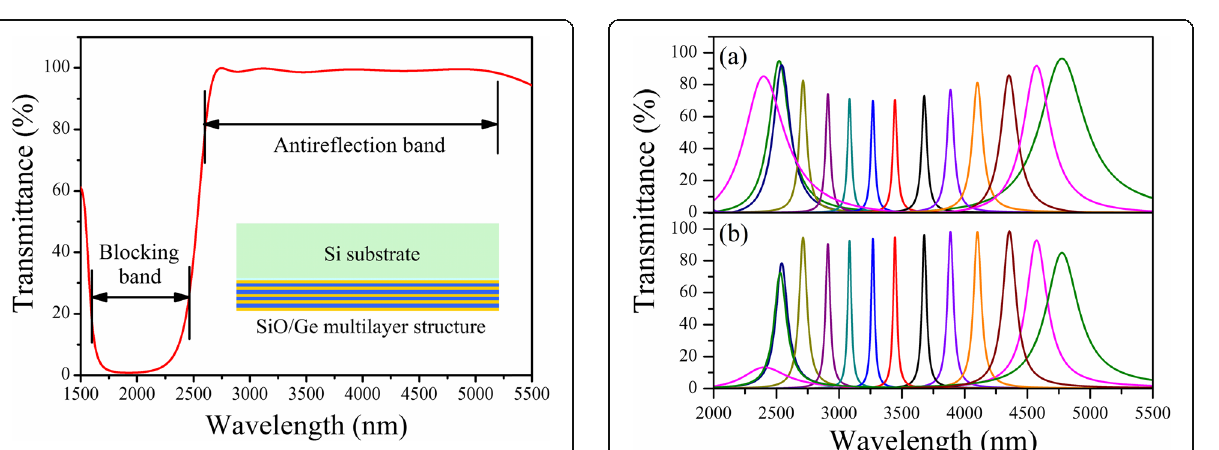
Fig. 4 Comparison of simulated transmittance spectra of LVOF without ( a ) and with ( b ) Ge/SiO multi-layer structure